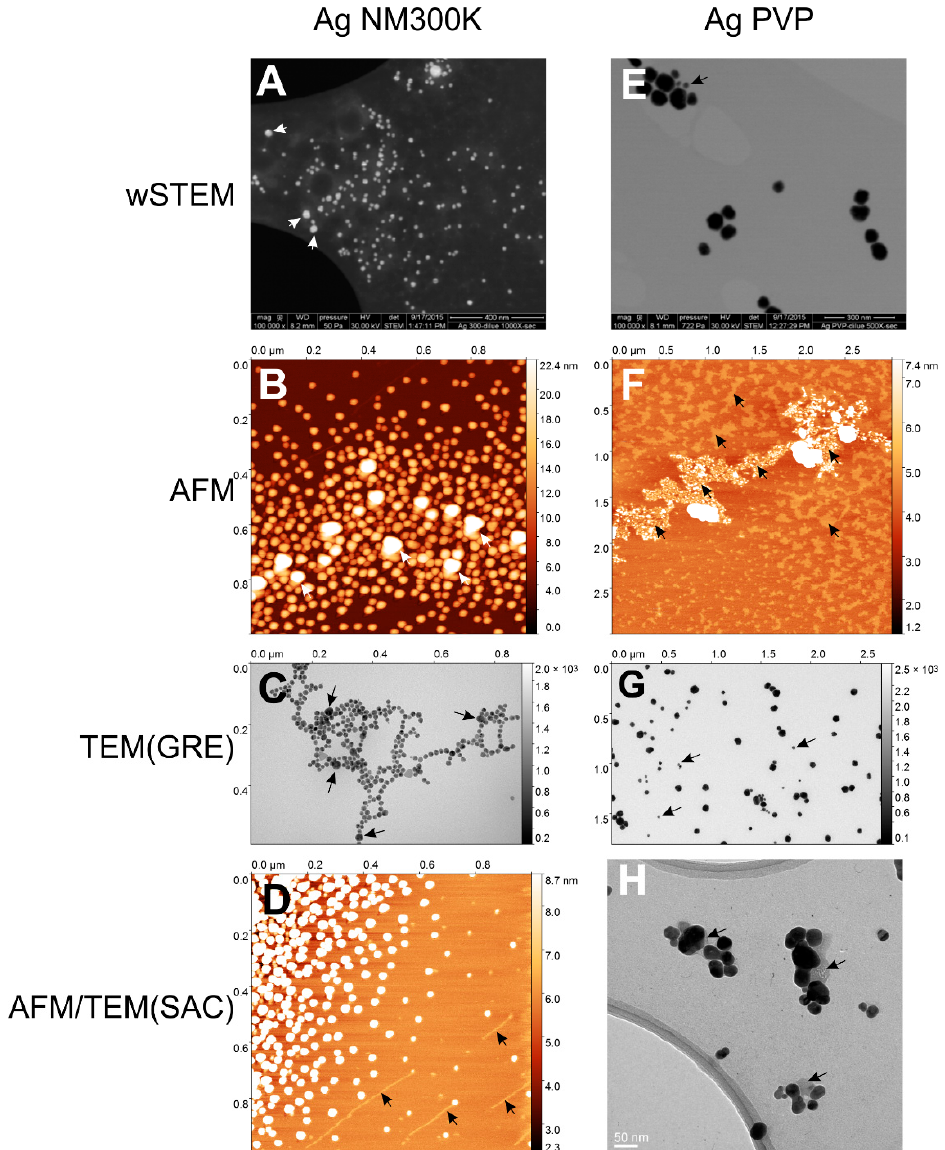
Figure 5. Samples of recorded microscopy images on silver NPs: ( A – D ) for Ag NM-300K; and ( E – H ) for Ag PVP. Whereas the global average of NM-300K size is 17.1 ± 3.5 nm, there is a presence of significantly larger NPs (indicated with black or white arrows) around 50 nm as observed in: wSTEM (dark field) ( A ); AFM ( B ); and TEM ( C ). Illustration of silver NPs stability as observed with AFM ( D ), where weakly bound NM-300K NPs were pushed around by the AFM tip (silver traces are indicated with black arrows) which results in a noticeable reduction in NPs height. Conversely, whereas the global average of PVP size is 55.8 ± 3.7 nm, there is a presence of smaller NPs (marked with black arrows) in wSTEM ( E ) and TEM ( G ) images. In AFM ( F ) and TEM(SAC) ( H ), the coating layer of PVP surrounding silver NPs is clearly seen (marked with black arrows), which is one explanation of the smallest average NPs size determined by AFM. Note that the color scale has been adjusted for the AFM data ( F ) so that the small height of PVP remains visible while NPs appear in bright white colors.